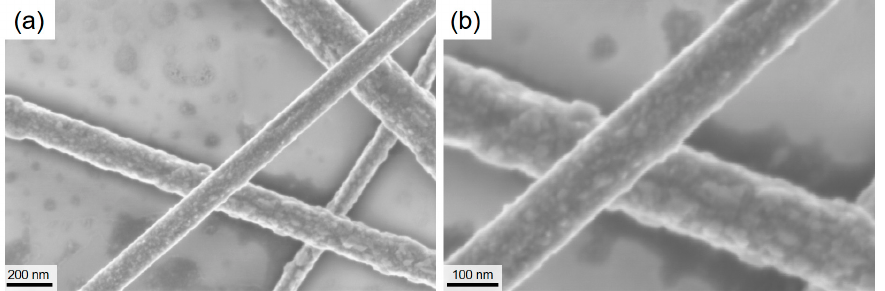
Figure A4. SEM-images for a CuNW film subjected to a relative humidity and temperature of 90%RH and 60 °C, for a duration of 24 h, under ( a ) a low and ( b ) a high magnification.